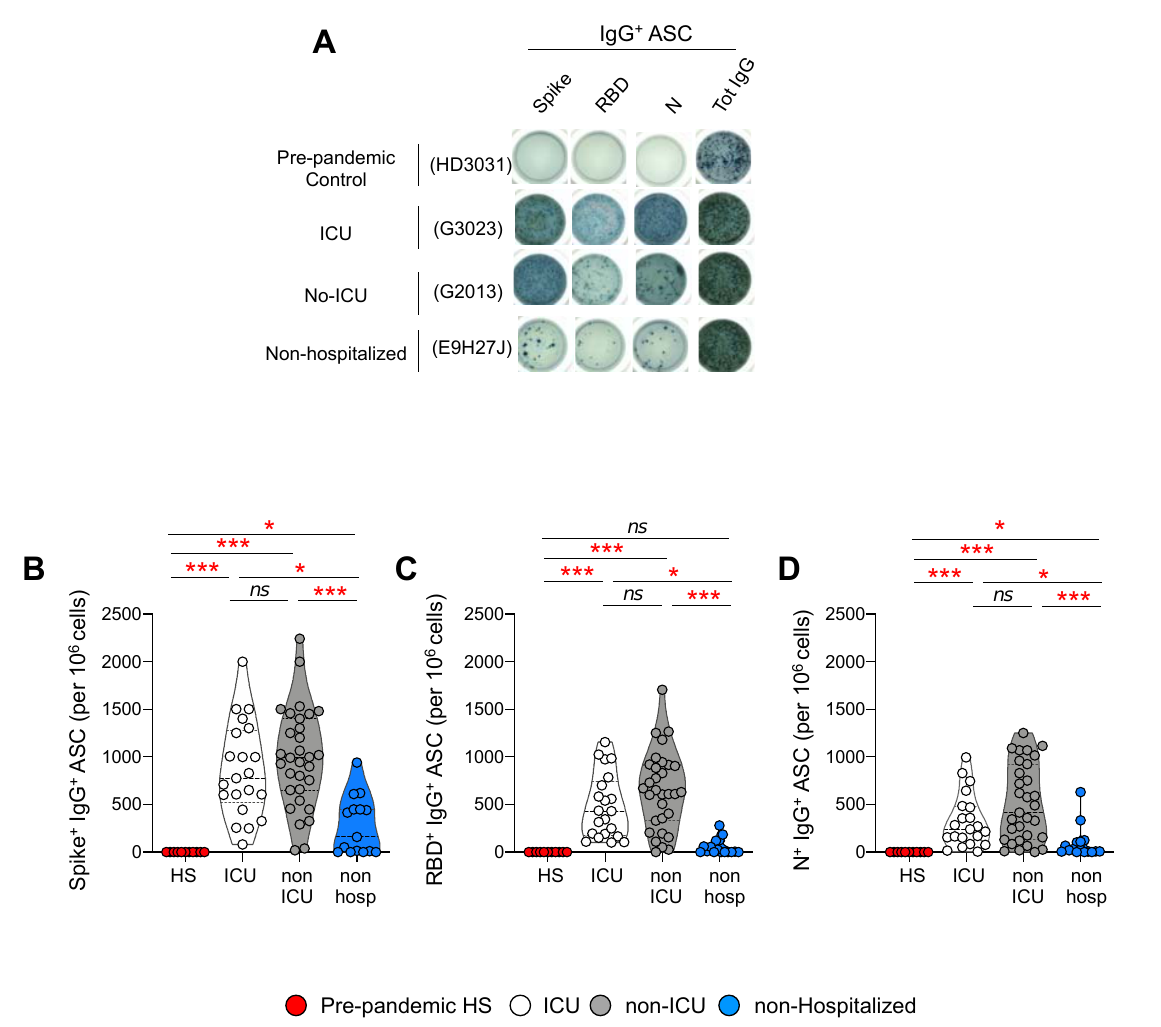
Figure 4. Frequencies of SARS-CoV-2+ antibody-secreting cells (ASCs) in ICU, non-ICU, and non-hospitalized individuals. PBMCs from ICU (N = 21), non-ICU (N = 31), and non-hospitalized (N = 15) individuals at 6 months POS and from pre-pandemic controls (N = 10) were cultured for 5 days in the presence of R848 (1 ug/mL) and IL-2 (10 ng/mL). The frequencies of SARS-CoV-2-specific cells (ASC) were measured by ELISPOT. ( A ) Representative counting of spot-forming cells (SFC) in representative ICU, non-ICU, non-hospitalized individuals, and one pre-pandemic control. Cumulative data on the frequencies of IgG+, ( B ) Spike, ( C ) RBD, and ( D ) N-specific ASCs in the different groups. p -values were obtained using a one-way ANOVA (Kruskal–Wallis test), followed by a Mann–Whitney test (intra-group comparisons). Red stars indicate statistical significance (* p < 0.05, *** = p < 0.001); ns = not significant.